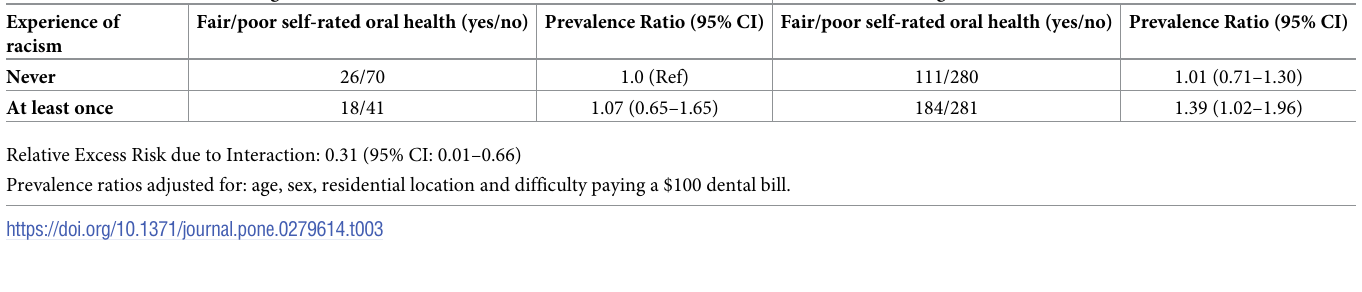
Table 3. Effect measure modification of negative life event on the effect between experience of racism and fair/poor oral health among Indigenous South Australians. No negative life event in last 12 months Negative life event in last 12 months Experience of racism